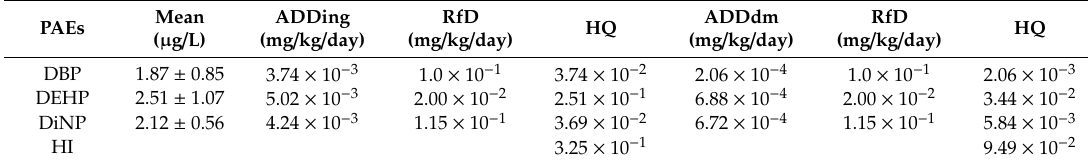
Table 4. HQ values of exposure to PAEs via ingestion and dermal contacts in adults.